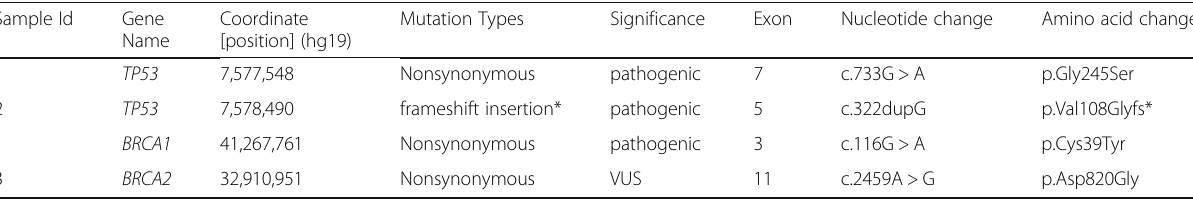
Table 1 List of clinically relevant mutations within the BRCA1 , BRCA2 and TP53 genes in resected breast tumor tissues in our Bangladeshi